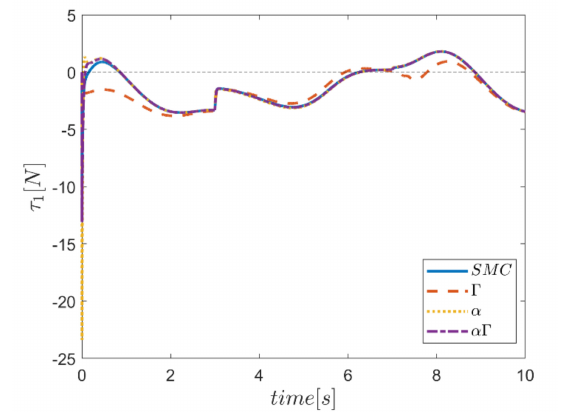
Figure 50. Comparison of the input force in the first